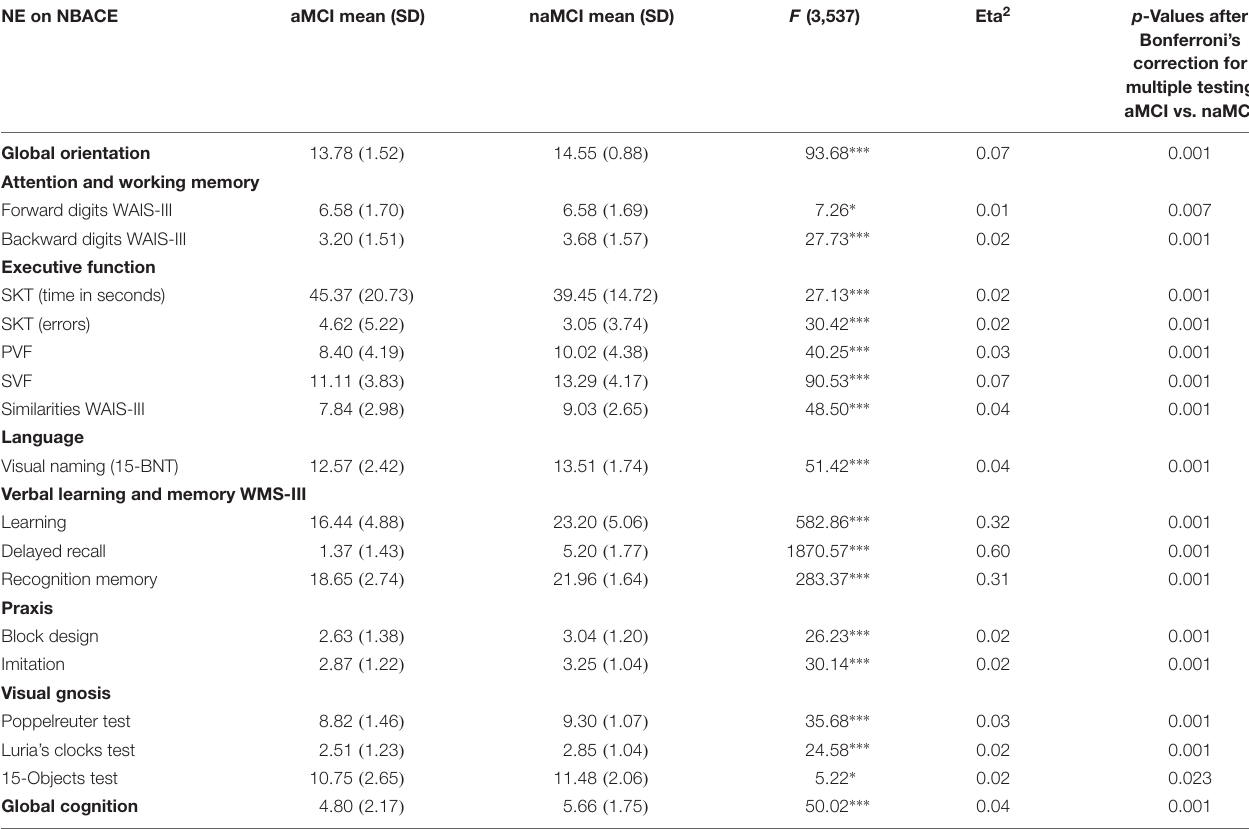
TABLE 2 | The ANCOVA comparing NE scores between aMCI and naMCI groups from the ACE dataset. NE on NBACE aMCI mean (SD) naMCI mean (SD) F (3,537) Eta 2 p -Values after